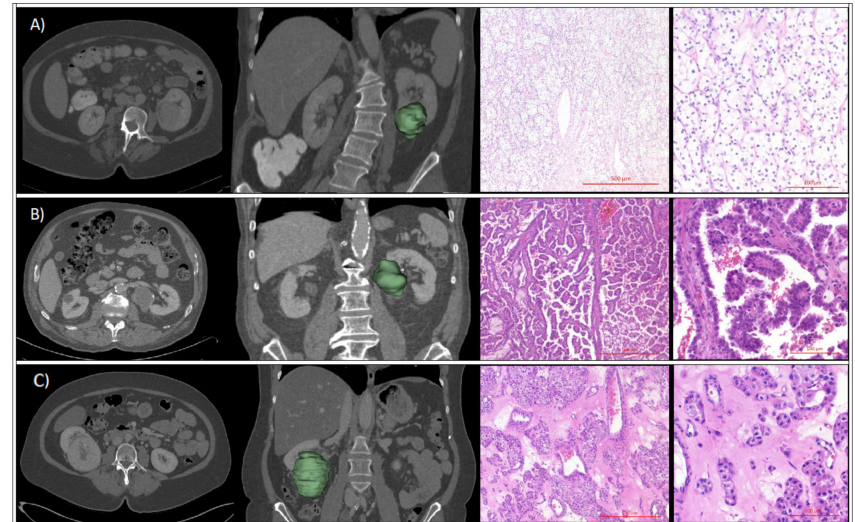
Figure 2. Clinical cases of patients presenting with: ( A ) left-sided renal tumor of the lower pole with heterogenous enhancement on venous-phase computed tomography (CT) with corresponding 3D-segmentation and histopathological HE-staining at 5 X and 20 X magnification, which revealed a ccRCC subtype; Scale Bar 500 µ m and 100 µ m; ( B ) left-sided central renal tumor with hypodense central attenuation, diagnosed as papillary RCC by histopathological analysis; Scale Bar 500 µ m and 100 µ m; ( C ) right-sided renal tumor of the middle and lower pole with heterogeneous enhancement and central scar-like hypodensity, that was confirmed as oncocytoma on histopathological assessment; Scale Bar 500 µ m and 100 µ m.